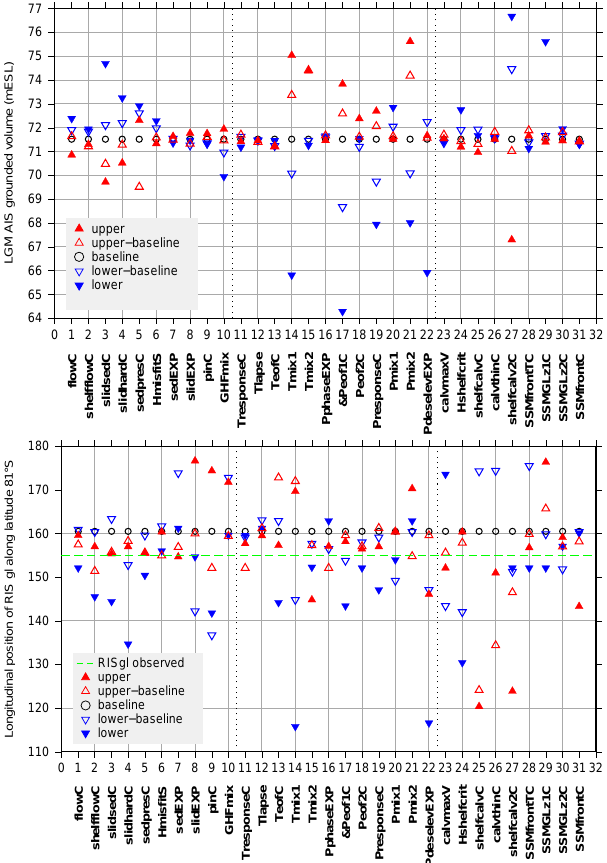
Fig. 10. Sensitivity results for ROS (upper) and RON-FIL (lower) present-day